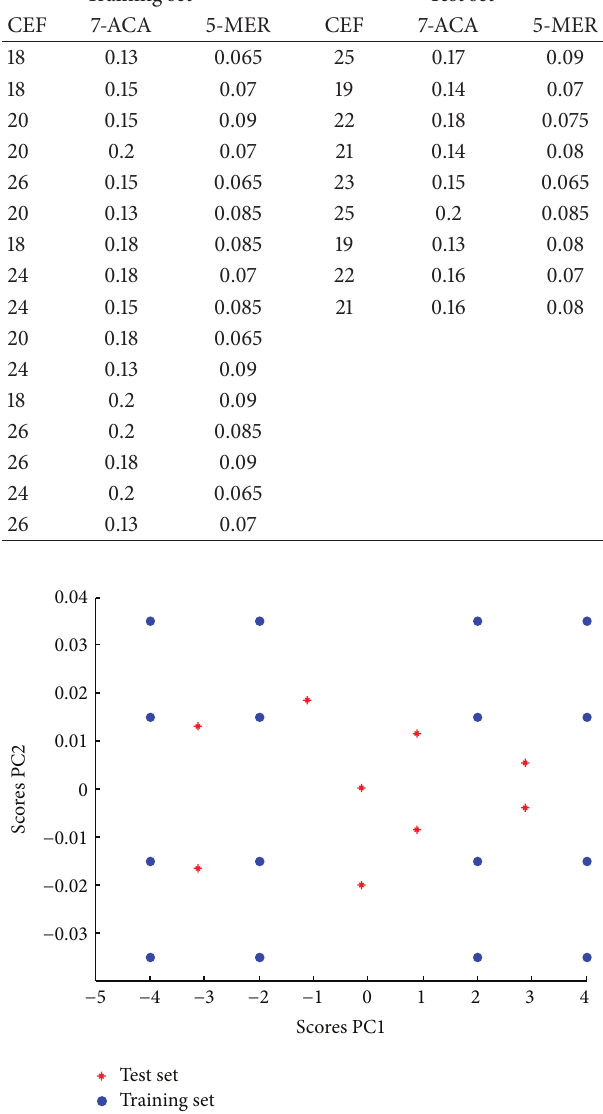
Figure 3: Two-dimensional scores plot for the mean centered 16 training set samples (circles) and the 9 test set samples (stars) of concentration matrices of the 4-level 3-factor experimental design, with % variance of 99.7% for first PC and 0.28% for second PC.